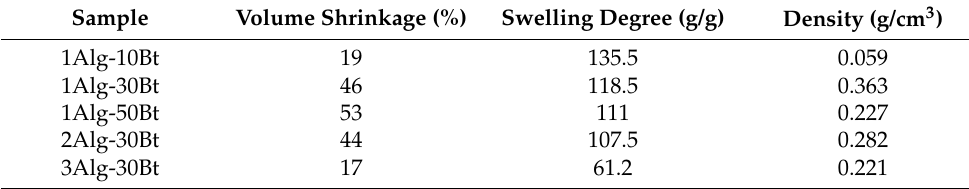
Table 2. Properties of aerogels with different ratios.